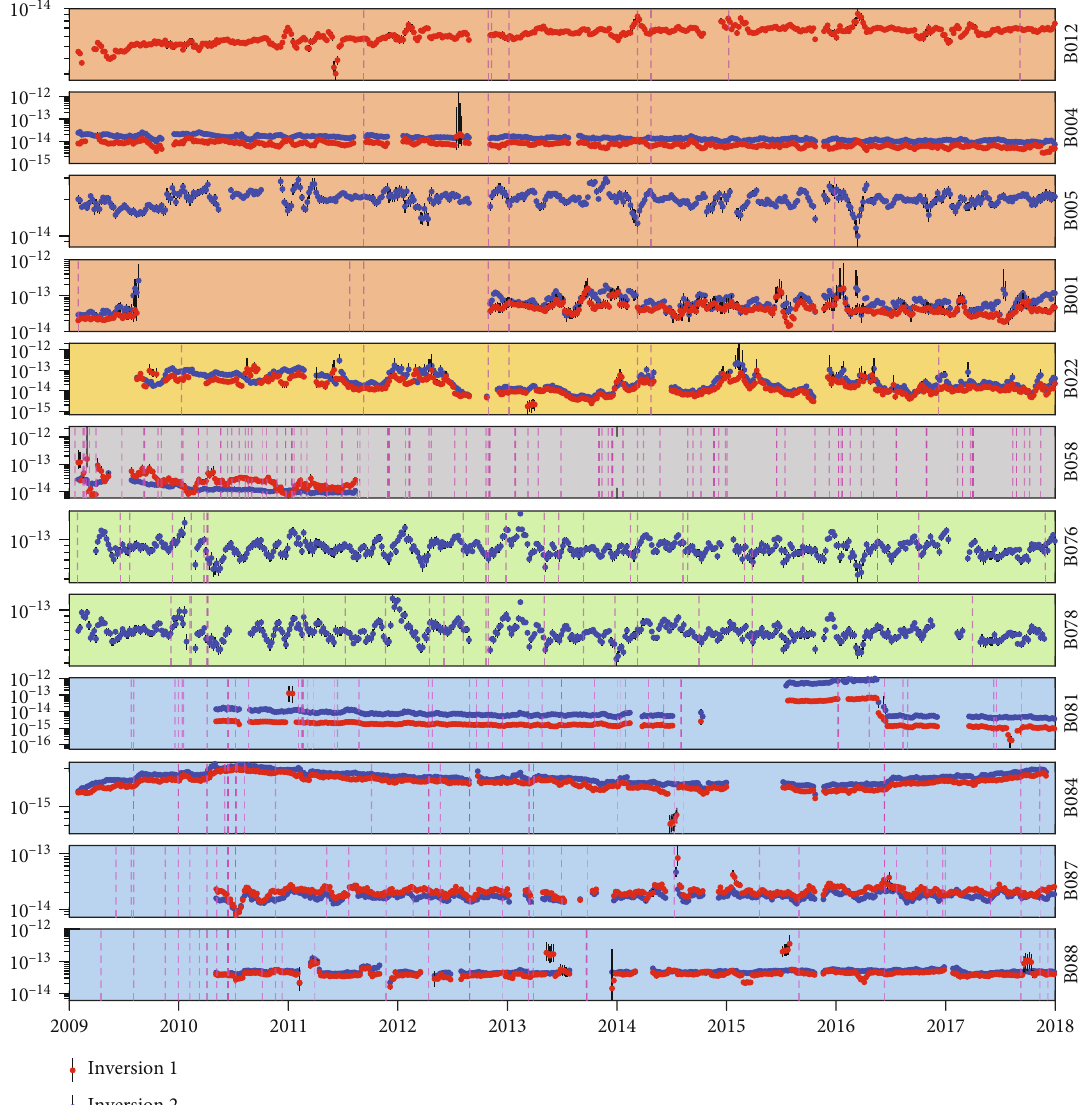
Figure 9: Permeability values over time for all boreholes. Earthquakes with a seismic energy density above 10 -3 J m -3 are plotted as magenta dashed lines. Error bars are within markers where not visible. Inversion 1 uses fi ltered borehole pore pressure and fi ltered modeled strain for analysis. Inversion 2 uses fi ltered borehole pore pressure and fi ltered strainmeter data for analysis. Background colors represent regions determined by geographic locality and similarity of local